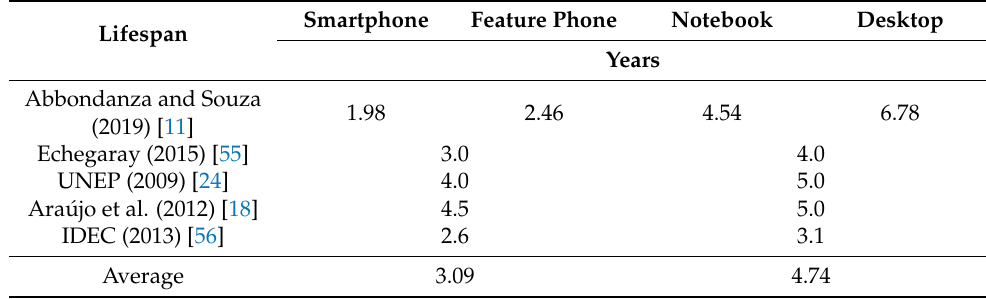
Table A2. The lifespan in years of end-of-life devices according to different authors in